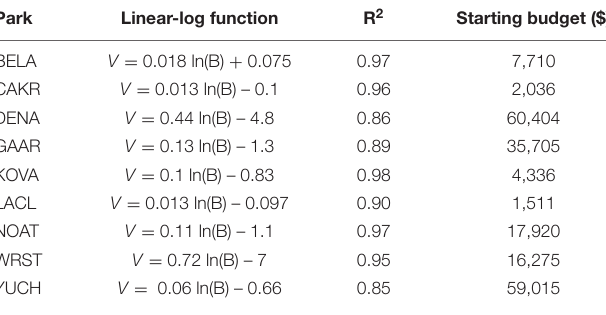
TABLE 3 | Park linear-log functions, R 2 values, and starting